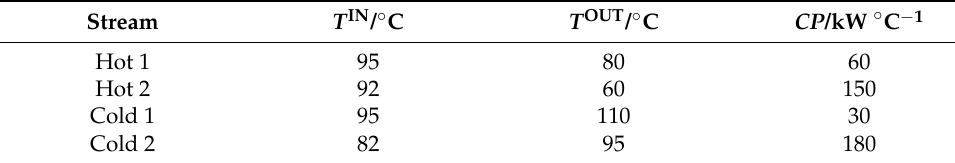
Table 1. Input data for process streams for case study 1.